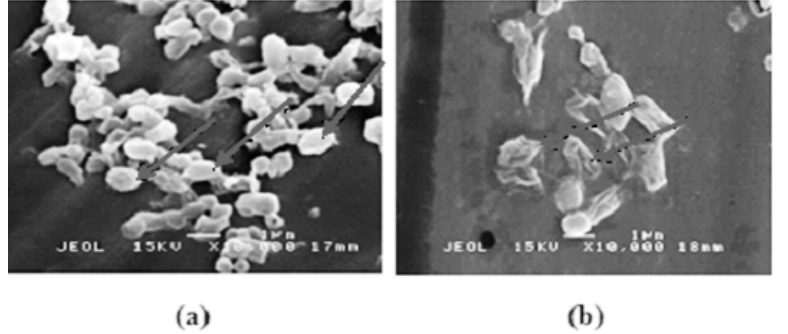
Fig. 1. Effect of methanolic S. polyanthum L. extract on Bacillus pumilus ATCC14884; (a) no extract, (b) with 1% extract for 1 table 3. Sporicidal activity of S. polyanthum L. against spores of B. pumilus and B. megaterium Concentration of CFU/ml of spores / glutaraldehyde or S. polyanthum L. extract / bacterial strain extract or Glutaraldehyde S. polyanthum L. extract